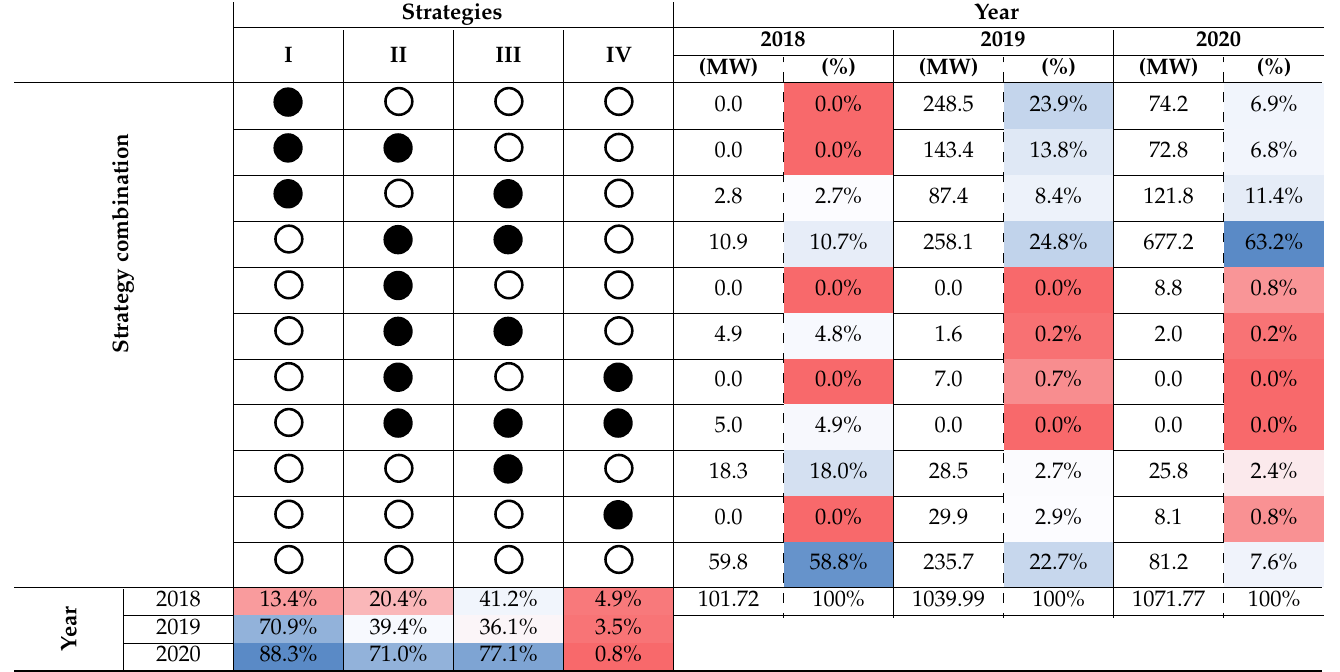
Table 2. Combination of strategies adopted by UVAMs in 2018, 2019 and 2020.